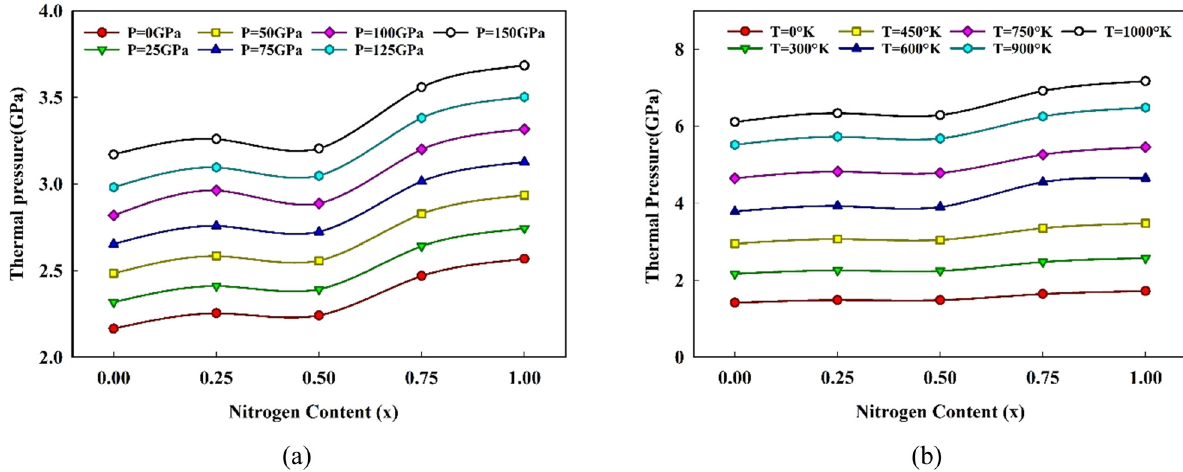
Figure 10: Thermal pressure of ZrC ( 1 − x ) N x as a function of nitrogen content ( x ) for ( a ) di ff erent pressures at 300 K and ( b ) di ff erent temperatures at zero